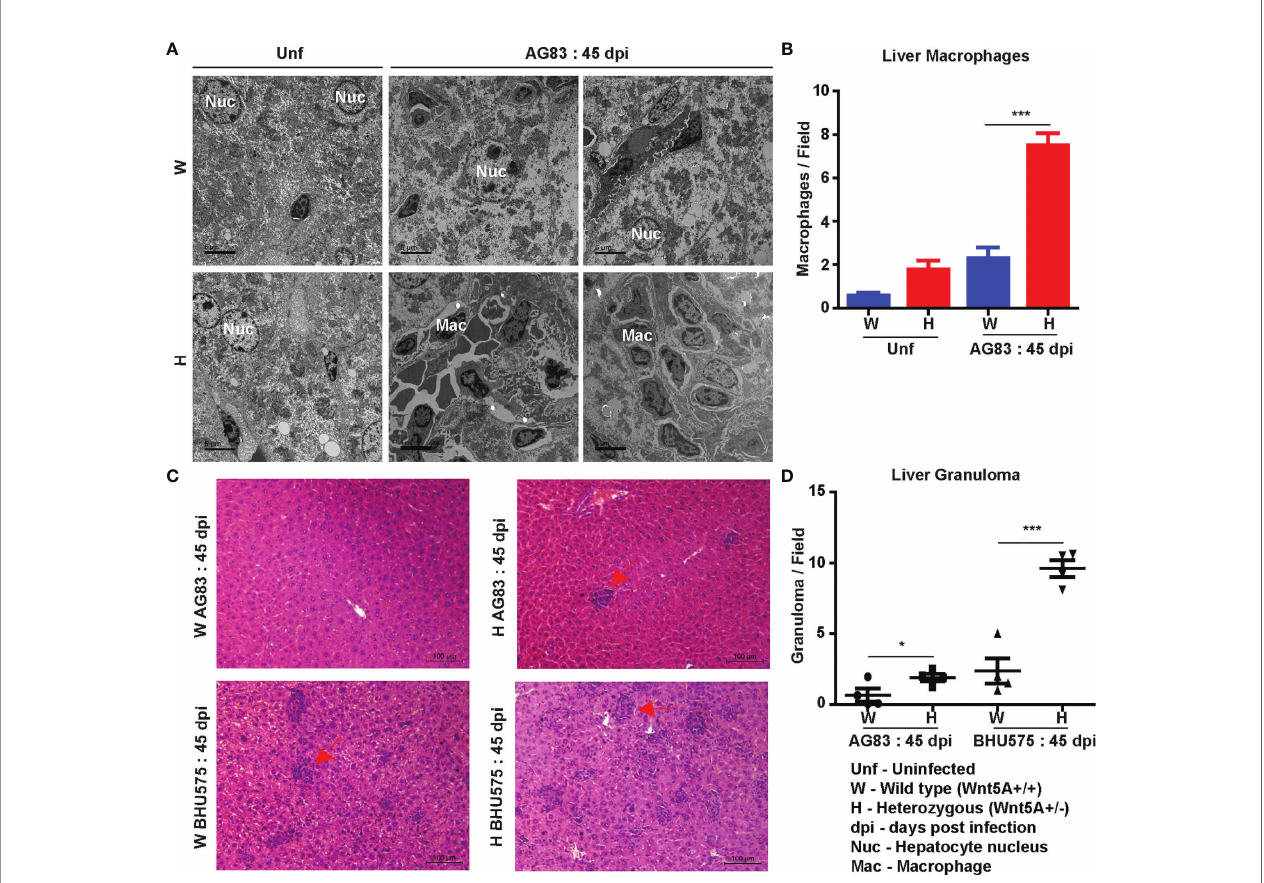
FIGURE 3 | Evaluation of liver pathology of H and W mice after L. donovani infection by transmission electron microscopy and histology. (A, B) TEM micrographs (A) and morphometric analysis (B) demonstrating increased numbers of monocytes/macrophages in the liver of H as compared W, 45 dpi. ‘ Uninfected ’ (Unf) from each category is used as reference. (C, D) Representation of liver granuloma (under 20X objective) in H as compared to W, 45 dpi as demonstrated by histology. Statistical analysis was performed with the unpaired t-test. Data from 10-20 fi elds are presented as mean ± SEM. Signi fi cance was annotated as follows: * p ≤ 0.05, *** p ≤ 0.0005. n=4 (per